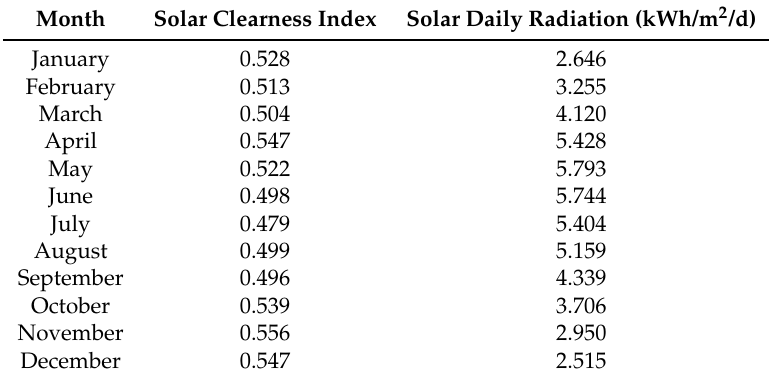
Table 2. Monthly solar resource information for